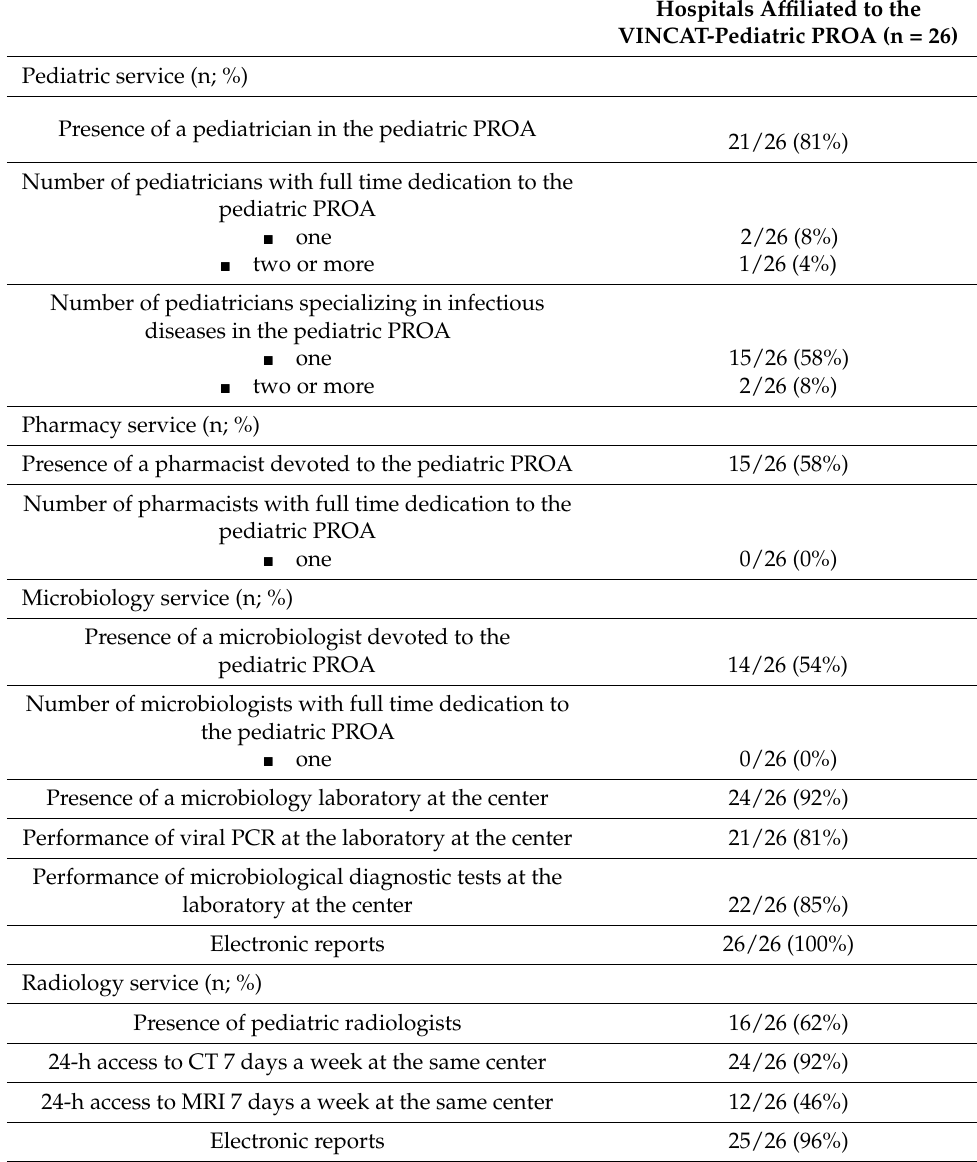
Table 1. Structure indicators of the participating